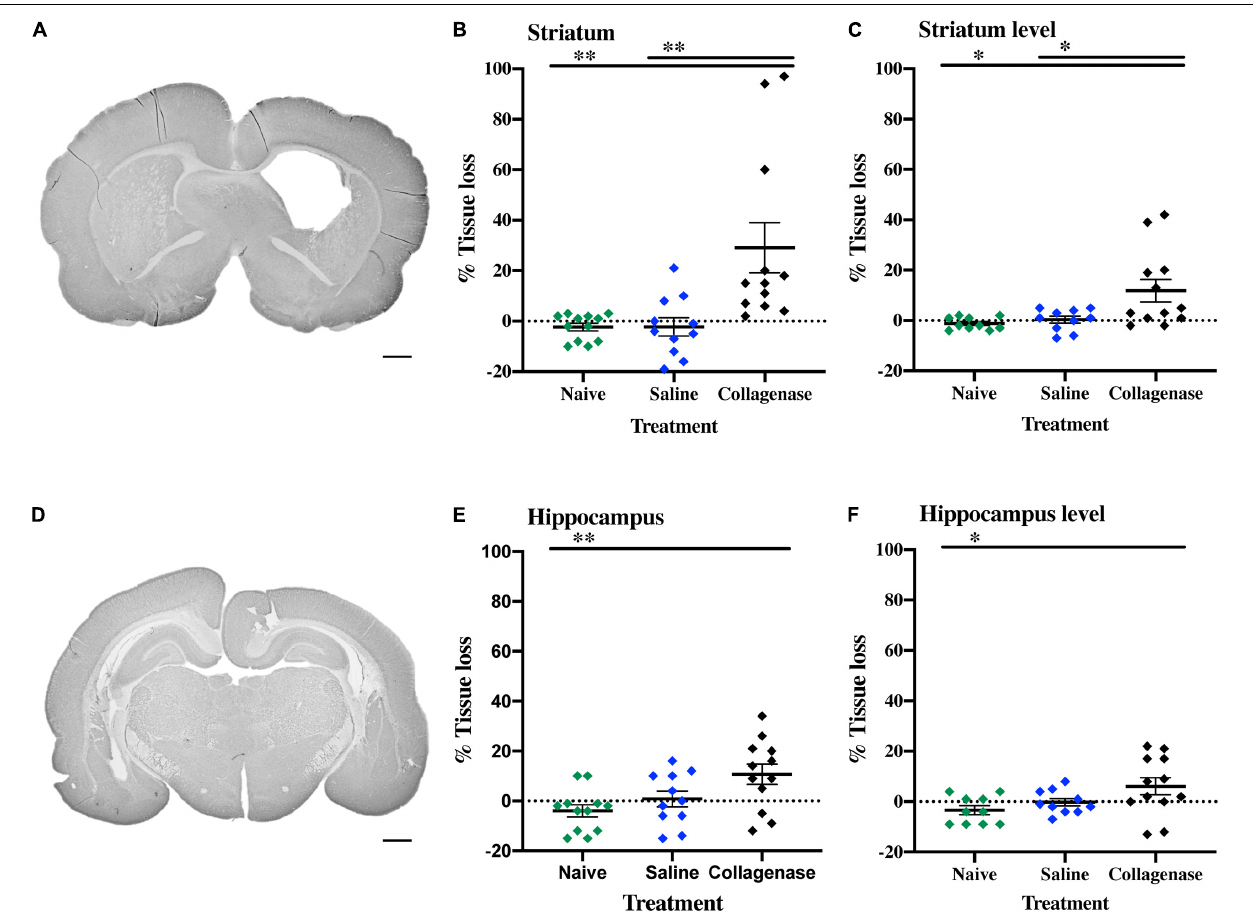
FIGURE 5 | Gray matter injury at P16. (A) Representative MAP-2-stained whole brain micrograph of 0.3 U collagenase-mediated striatal injury at P16. (B) Graph demonstrating striatum-specific tissue loss and (C) striatum level ipsilateral hemisphere loss in the collagenase group. (D) Representative MAP-2-stained whole brain micrograph of 0.3 U collagenase-mediated hippocampal injury at P16. (E) Graph demonstrating hippocampus-specific tissue loss and (F) hippocampus level ipsilateral hemisphere loss in the collagenase group ( n = 12). Both naïve ( n = 10) and saline-injected ( n = 10) animals were used as control groups. Data represented as individual animals ± SEM and analyzed using one-way ANOVA followed by Tukey’s multiple comparison test. ∗ P < 0.05 and ∗∗ P < 0.01. Scale bar = 1 mm.